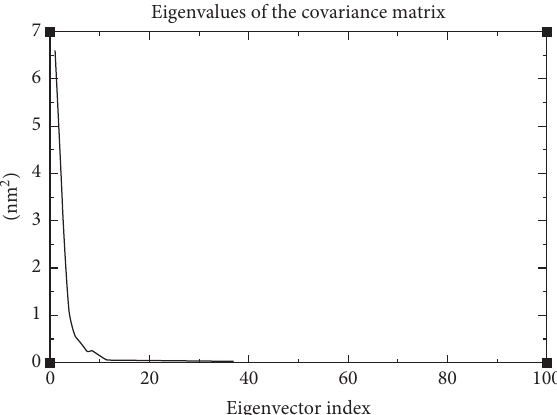
Figure 11: *e number of hydrogen bonds calculated over 10ns MD simulation.